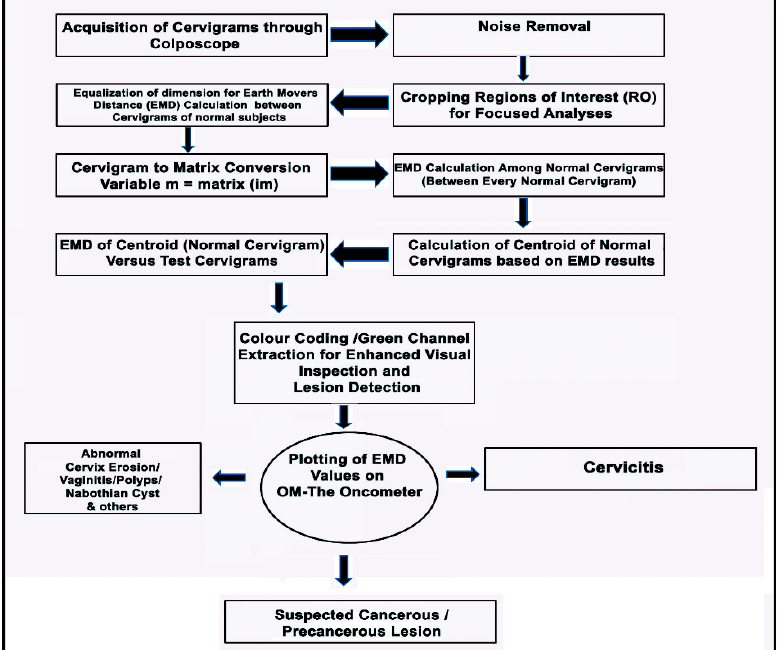
Figure 1. Diagrammatic representation of steps involved in pre-processing and processing of digitized cervigrams for detection of abnormality: our present study depicts a diagrammatic representation of the processing the digitized cervigrams obtained from the patients evaluated at the outpatient department of Batra Hospital and Medical Research Centre. The pre-processing algorithms include noise removal associated with the extraction of the image features (digitized cervigrams in this case) before cropping the raw image of cervigrams to define the regions of interest for equalization of the dimensions before being processed with Earth Mover’s Distance.